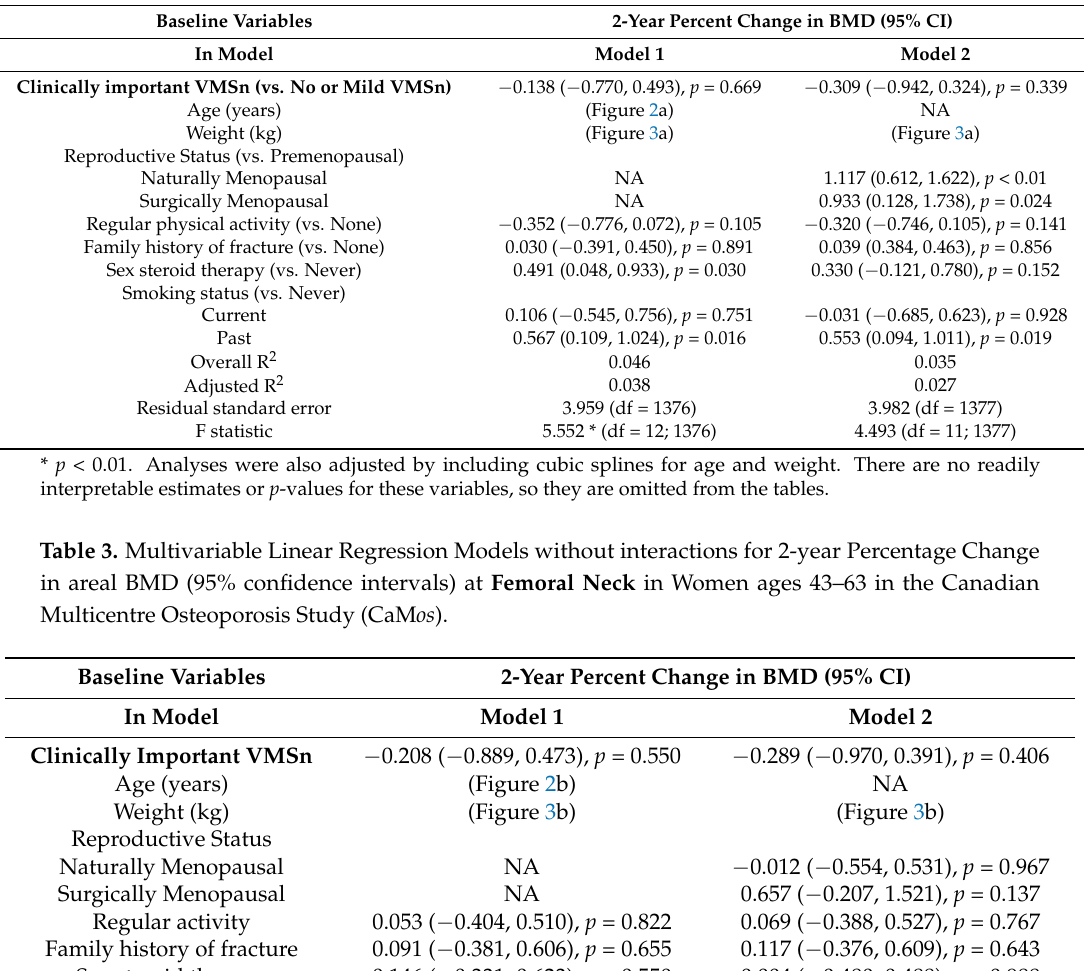
Table 2. Multivariable Linear Regression Models without interactions for 2-year Percentage Change in areal BMD (95% confidence intervals) at Lumbar Spine (L1-4) in Women ages 43–63 in the Canadian Multicentre Osteoporosis Study (CaM os ).